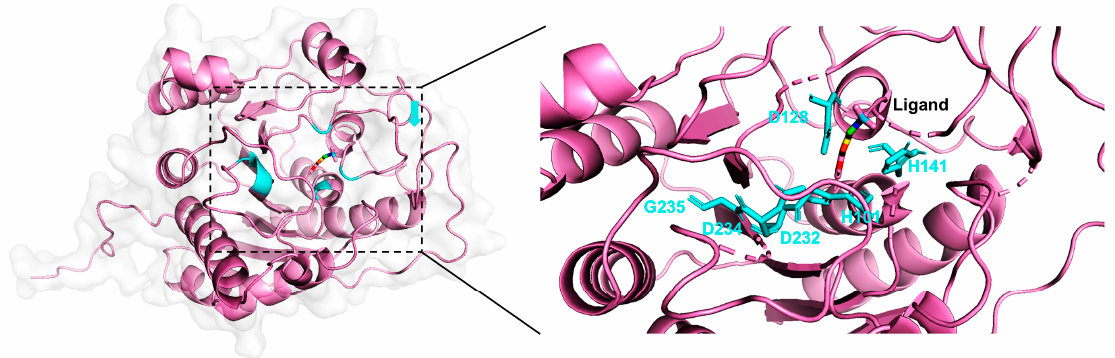
Figure 7. View of predicting effects of residue mutation on the catalytic efficiency of the amino acid hydrolysis reaction (Arginase, PDB:1RLA). Regions of mutated sites that decrease catalytic efficiency are highlighted in cyan on the cartoon. Ligand is shown as sticks in the rainbow.